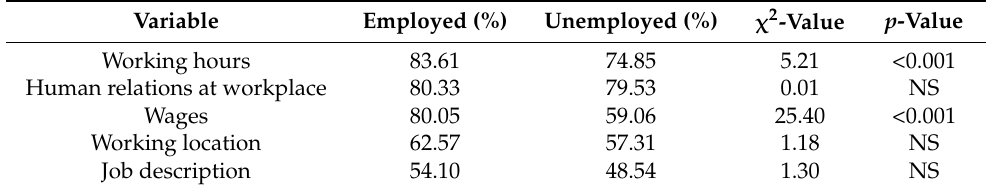
Table 4. Relationship between employment status and employment